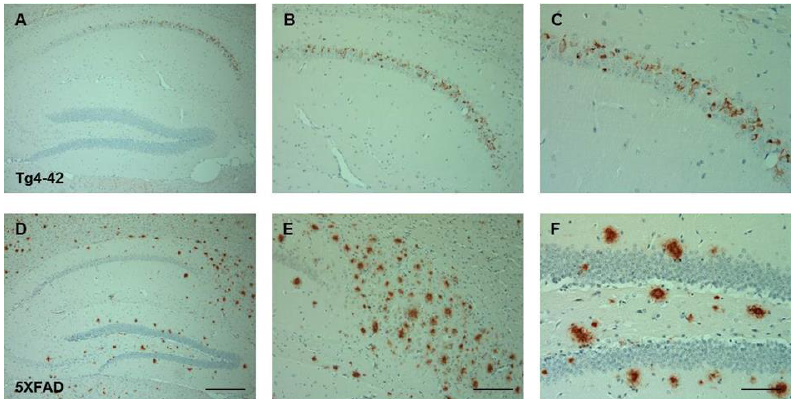
Figure 1. Amyloid pathology in 3-month-old Tg4-42 and 5XFAD. Immunohistochemical staining showing Tg4-42 as an example for an Alzheimer’s disease (AD) mouse model with intraneuronal Aβ